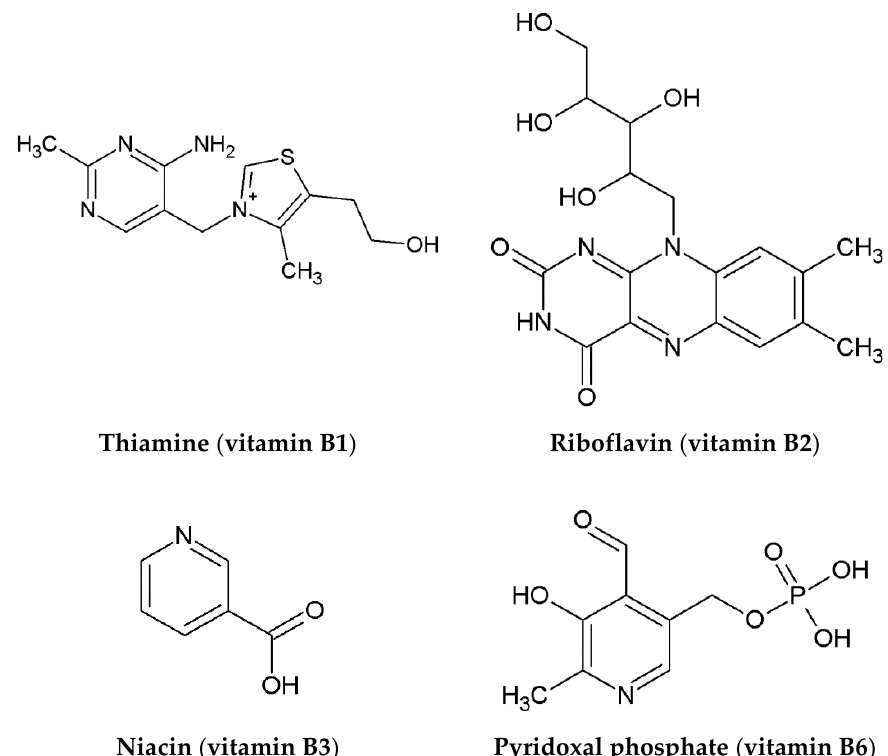
Figure 4. B vitamins chosen for the current study. The N 1 and N 7 atoms are indicated.